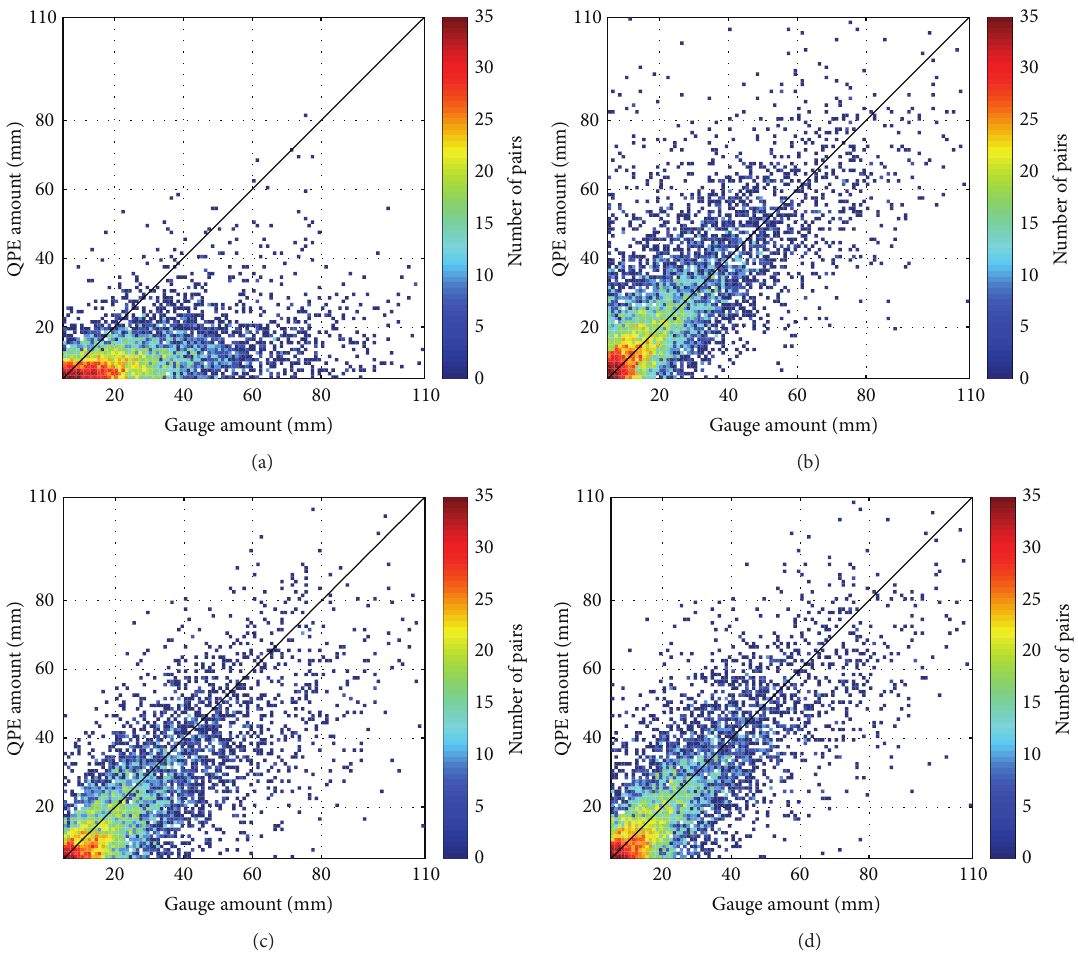
Figure 8: The comparison results between gauge network observations and QPE using (a) RZ, (b) RKDP, (c) CA, and (d) VCCA. 72-hour data from typhoon Morakot (08/08/2009 ∼ 08/09/2009) and Fanapi (09/19/2010) are selected, and a total of 17090 QPE-gauge pairs are used in the